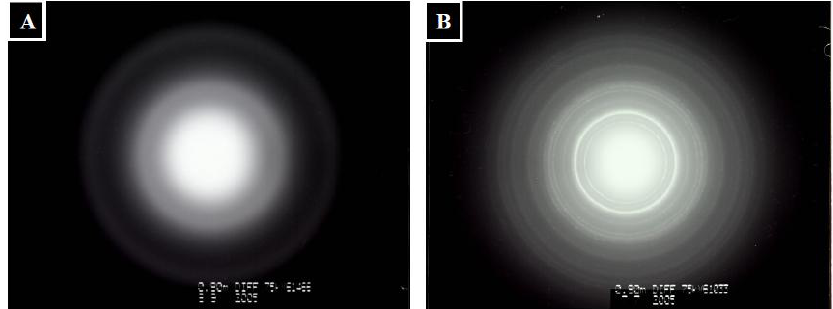
Figure 7. TEM electron diffraction patterns of ( A ) original TPP-CG composites and ( B ) mineral deposition on TPP-CG composites immersed in 1.5 × SBF for 21 days after pretreated with Ca(OH) . 2